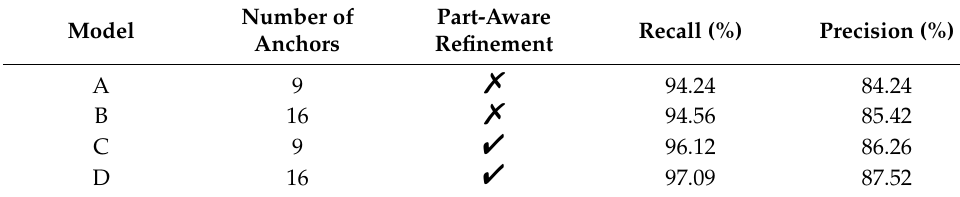
Table 1. Detection results before and after algorithm training strategy improvement.